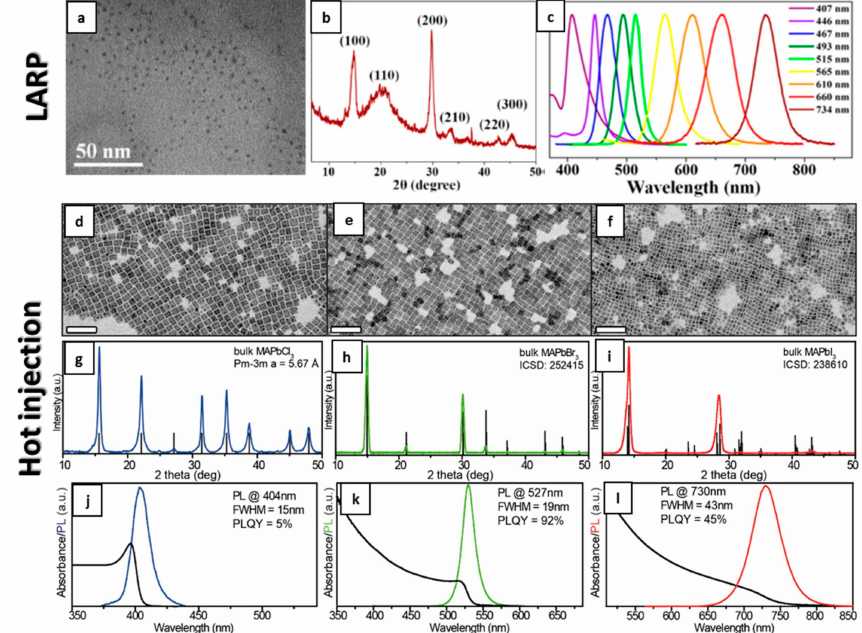
Figure 2. ( a – c ) MAPbX 3 NCs synthesized by LARP reproduced with permission from Ref. [14], Copyright (2015) American Chemical Society: ( a ) Transmission electron microscope (TEM) image and ( b ) X-ray diffraction (XRD) pattern of MAPbBr 3 NCs, ( c ) photoluminescence (PL) spectra of MAPbX 3 NCs. ( d – l ) MAPbX 3 NCs synthesized by the hot-injection method reproduced with permission from Ref. [17], Copyright (2018) American Chemical Society: Bright field TEM images (Scale bars